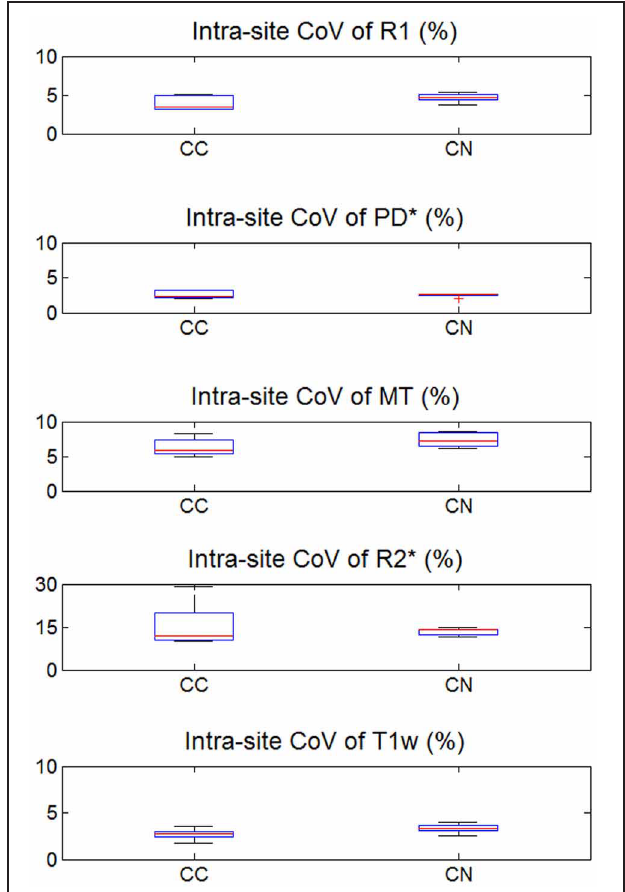
FIGURE 5 | Intra-site coefficient of variation (CoV) of R1, PD ∗ , MT, and R2 ∗ parameter maps and T1w images intensity values. Values were determined separately for caudate nucleus (CN) and genu of the corpus callosum (CC). For explanation of the whisker plot, see Figure 2 .